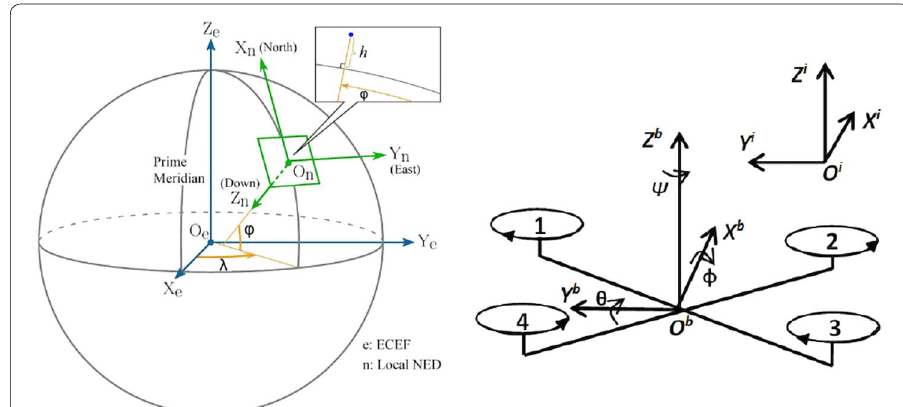
Fig. 2 Geodetic coordinate system, expressed in latitude ( ϕ ), longitude (λ) and altitude (h) (left) [15], and body coordinate system expressed in X b , Y b , Z b (right)